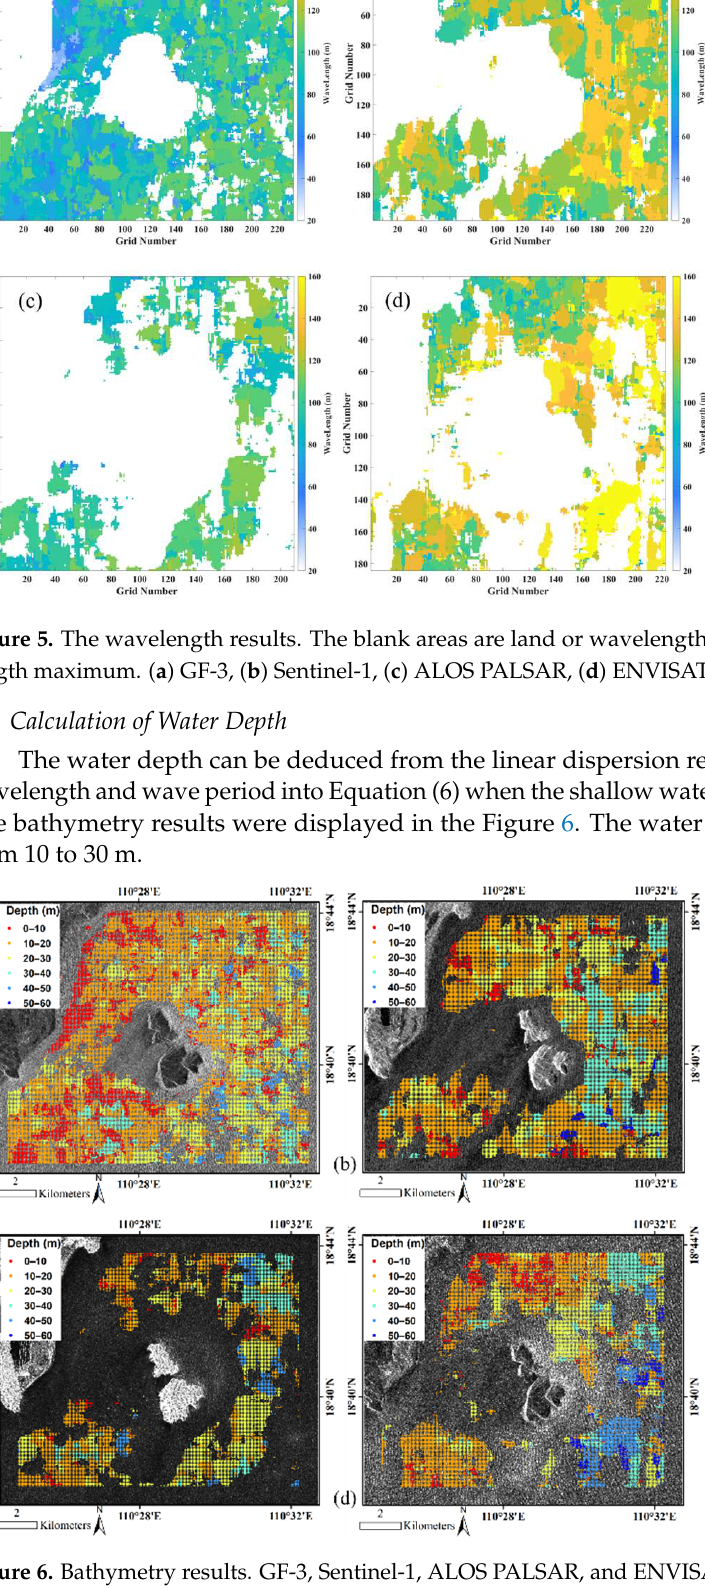
Figure 6. Bathymetry results. GF-3, Sentinel-1, ALOS PALSAR, and ENVISAT ASAR were shown in the ( a – d ).